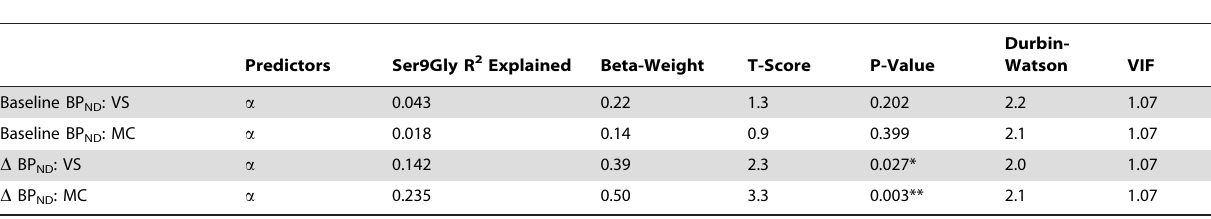
Table 2. Linear Regression Showing Effects of Ser9Gly on Raclopride Binding and Anhedonia